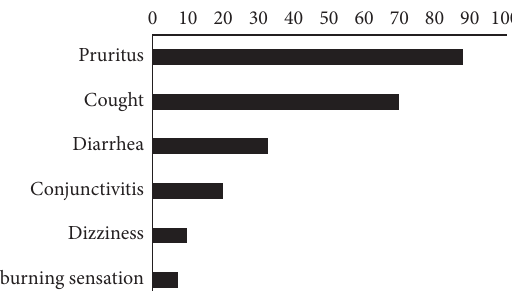
Figure 1: Distribution of market gardeners according to adverse health effects due to